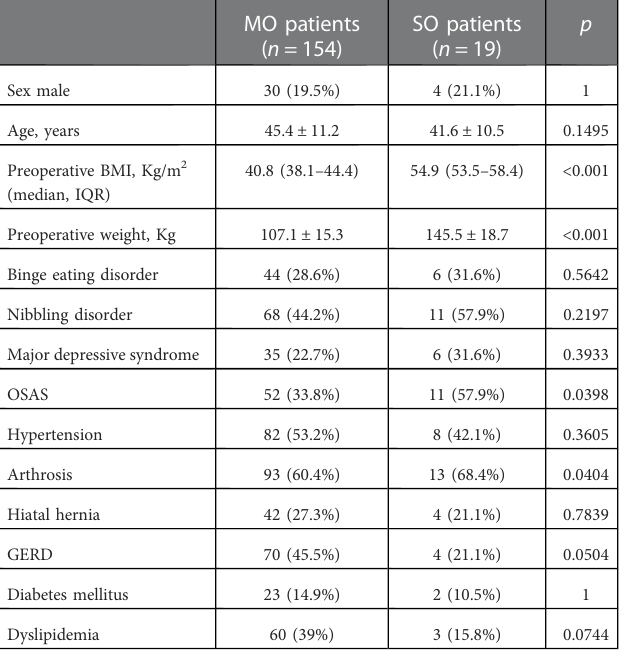
TABLE 1 Preoperative features.